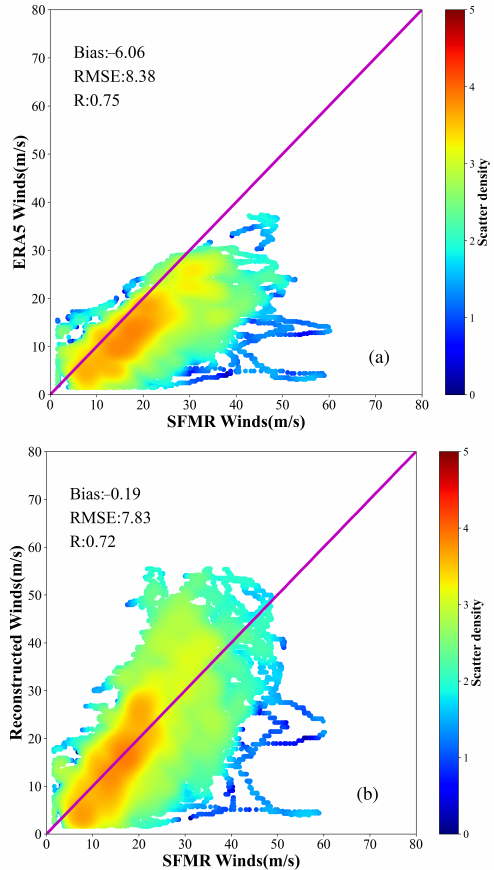
Figure 5. Scatter plots of wind speeds between SFMR and before and after reconstruction. The color scale is the common logarithm of the number of data points. ( a ) Comparison of wind speeds between SFMR and ERA5, ( b ) Comparison of wind speeds between SFMR and